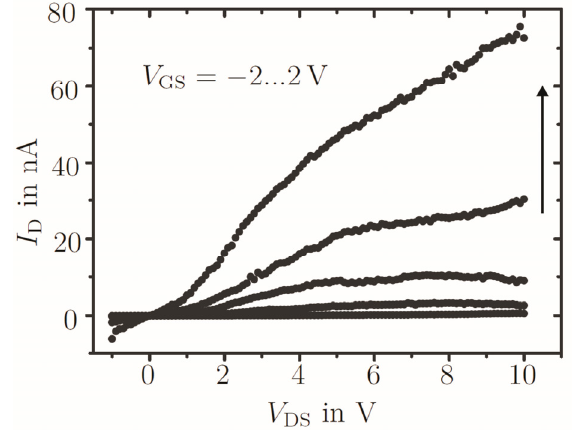
Figure 13. Output characteristics of a noninverted staggered ZnO nanoparticle TFT integrated by SWEB technique (L = 300 nm, W = 20 µm and t ox = 120 nm). © 2015 IEEE. Reprinted, with permission, from